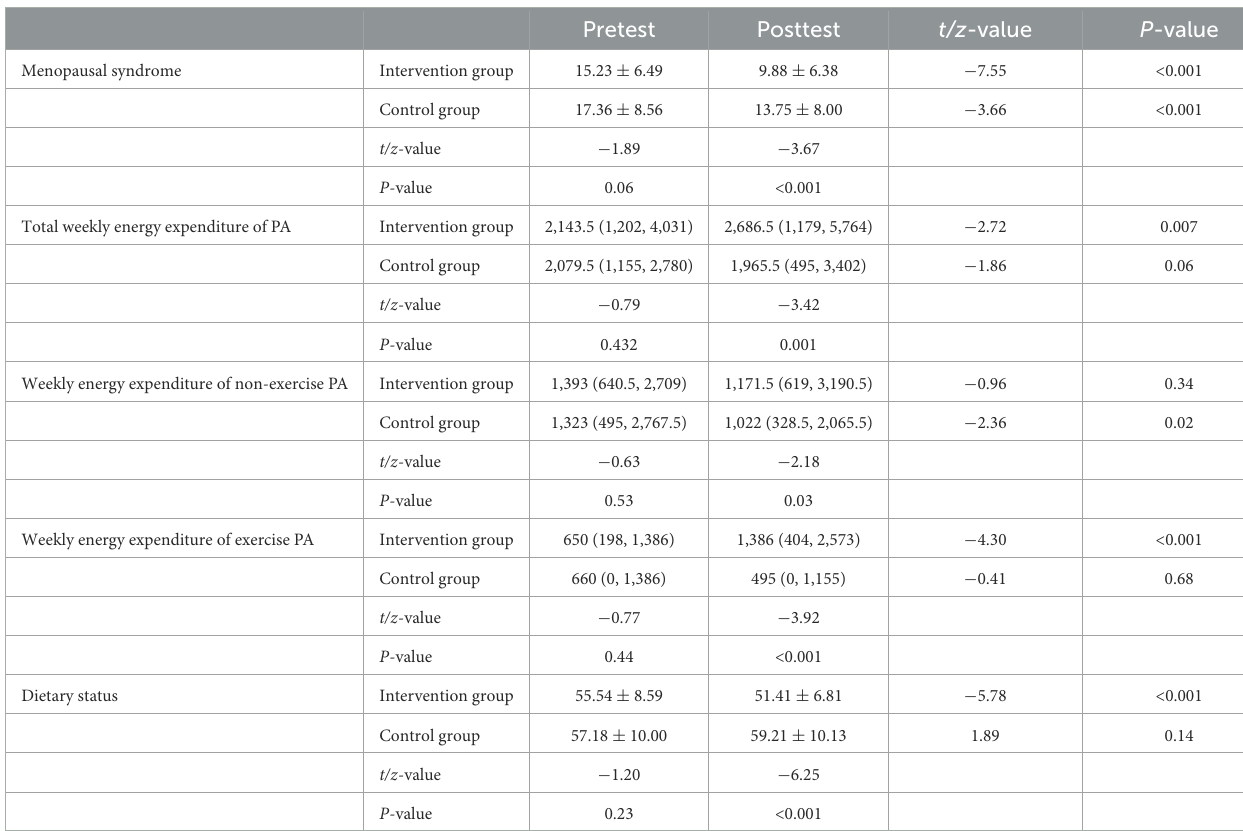
TABLE 3 Comparison of mKMI, IPAQ and dietary status within and between